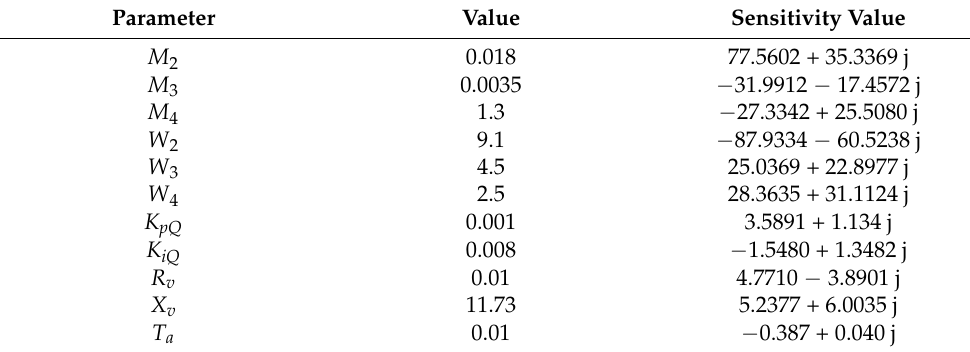
Table 2. Sensitivity of the parameters in the DFIG-IFLVSG grid-connected